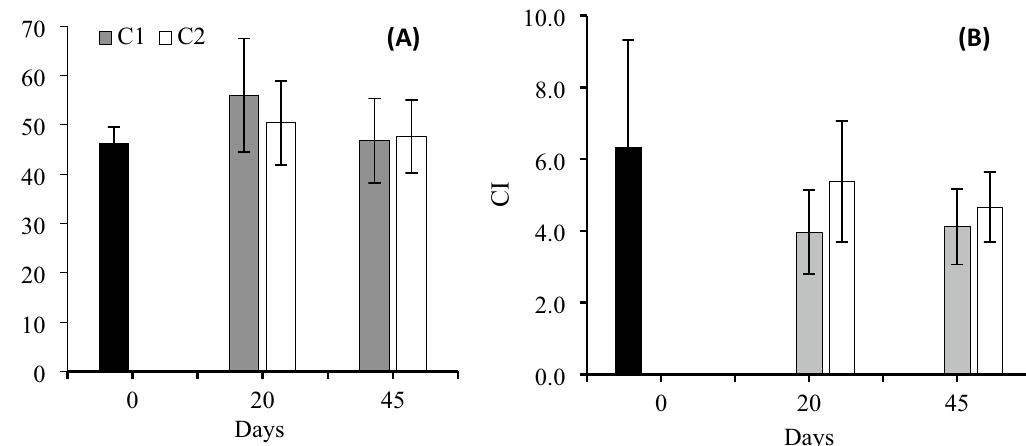
Figure 1. Total weight and condition indices (CI) during 45 days of pre-conditioning of the Pacific oyster C. gigas in two experimental conditions. Black bars, day 0; Grey bars C1, recirculating aquaculture system (RAS) without calcium reactor (control), and white bars C2, RAS with the calcium reactor. Biometry and CI were evaluated on days 0, 20, and 45. ( A ) Total weight (g); ( B ) Condition index. The error bars represent the standard deviation from the